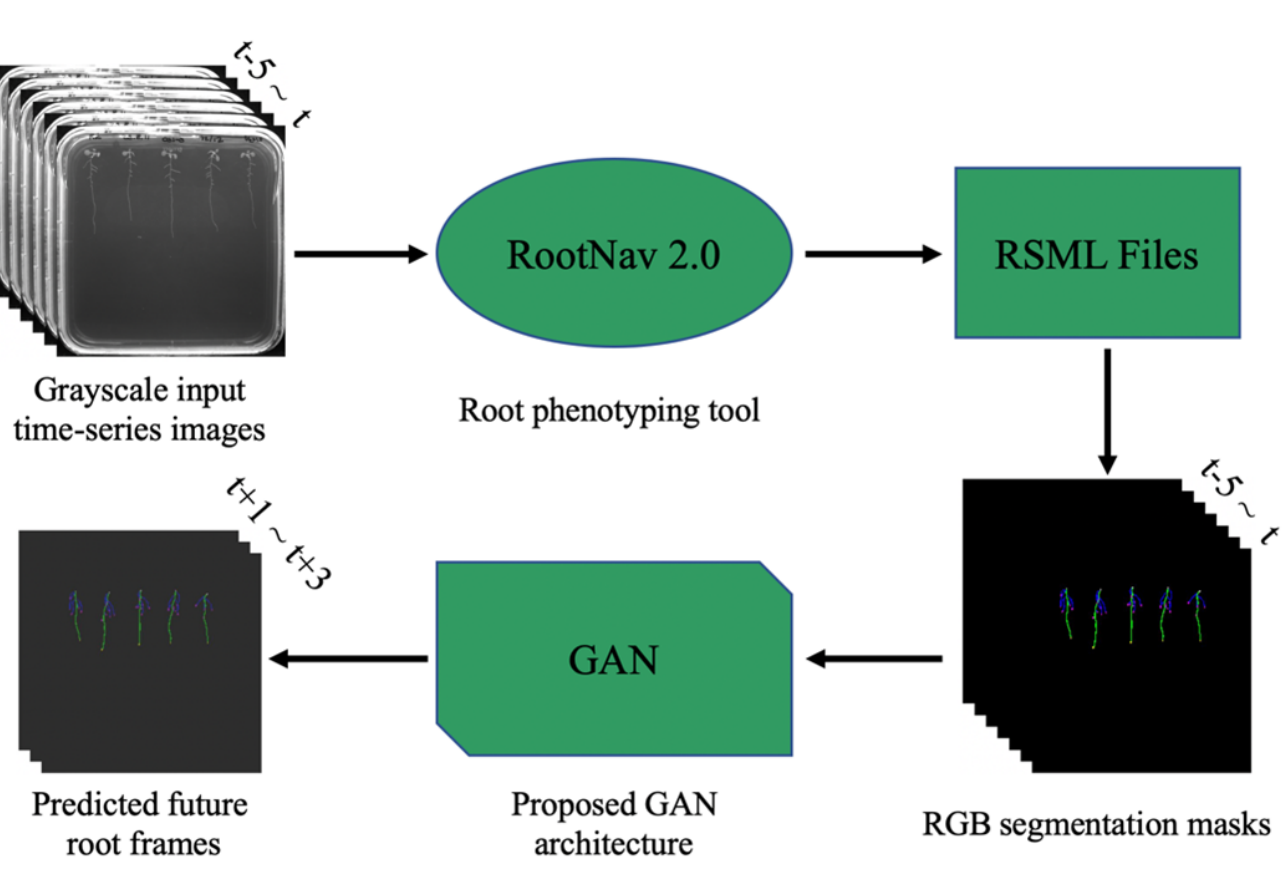
Figure 4. The proposed plant root phenotyping and growth prediction architecture for time-series image